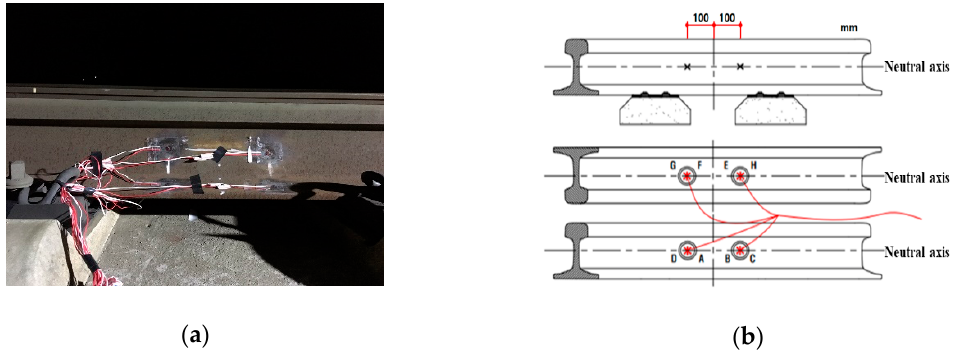
Figure 6. Wheel load gauge installed. ( a ) Gauge adhesion; ( b ) Instruction.